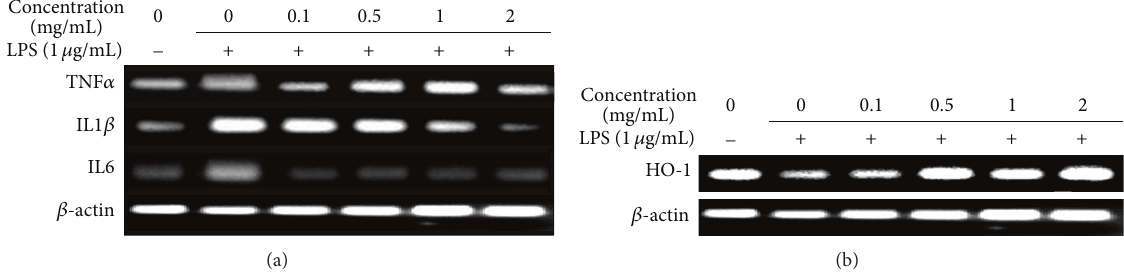
Figure 4: Effect of AM on expressions of inflammatory cytokines and HO-1 gene in LPS-stimulated RAW 264.7 cells shown by RT-PCR. The cells were treated with various concentrations of AM for 1h prior to the addition of LPS and the cells were further incubated for 24 h.